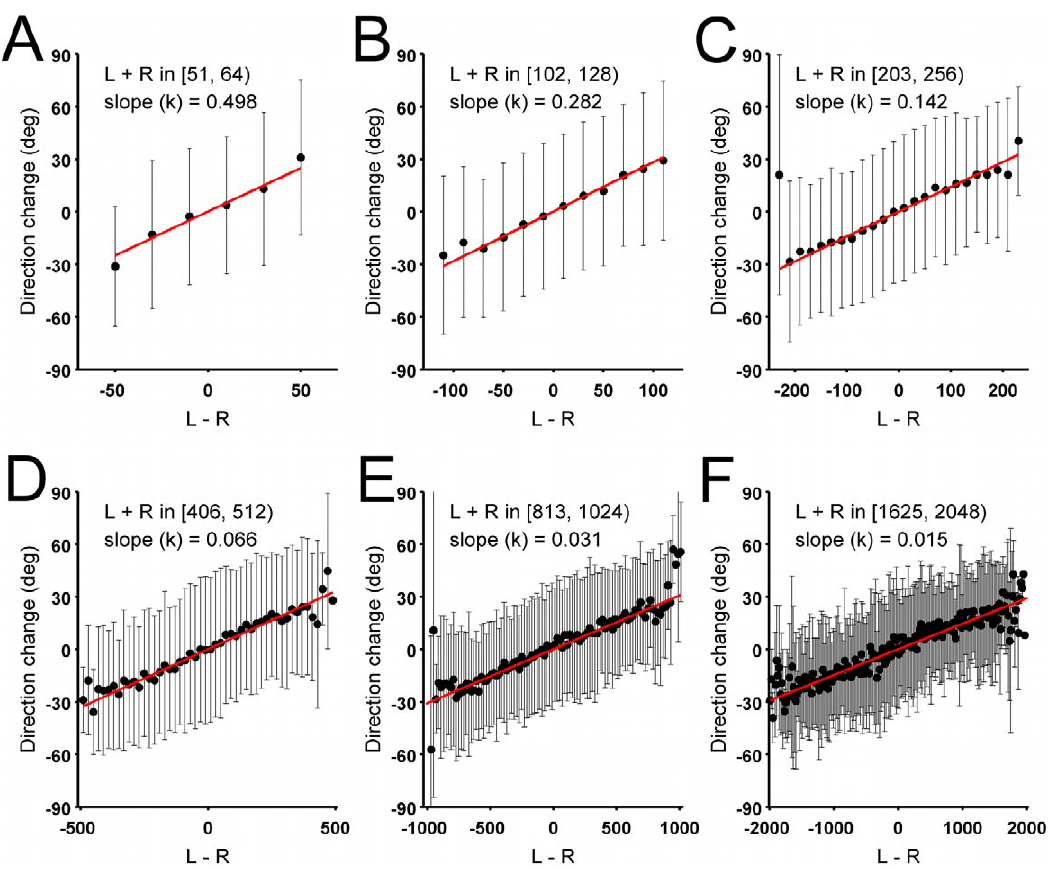
Figure 5. Measured angles of changes in direction made by ants as a function of pheromone difference ( L { R ) . Each graph is for a different range of values of total pheromone ( L z R ) . Given the large number of data points involved in the plot, and to improve visualization, we only report the mean and standard deviation of data binned in intervals of 20 pheromone units. The red line is a linear fit (on the unbinned data) of the form y ~ kx . Statistics on the fitted slope k are as follows: (A) k ~ 0 : 4981 ; F 33953,1 ~ 741 , p v 0 : 001 ; R 2 ~ 0 : 0214 . (B) k ~ 0 : 2820 ; F 27112,1 ~ 1171 , p v 0 : 001 ; R 2 ~ 0 : 0414 . (C) k ~ 0 : 1416 ; F 22152,1 ~ 1836 , p v 0 : 001 ; R 2 ~ 0 : 0766 . (D) k ~ 0 : 0662 ; F 17799,1 ~ 2303 , p v 0 : 001 ; R 2 ~ 0 : 1146 . (E) k ~ 0 : 0307 ; F 17591,1 ~ 3558 , p v 0 : 001 ; R 2 ~ 0 : 1682 . (F) k ~ 0 : 0146 ; F 10864,1 ~ 2102 , p v 0 : 001 ; R 2 ~ 0 : 1621 . Angles increase anticlockwise: positive angles indicate an ant turn to the left. The data from all the trials are merged for this